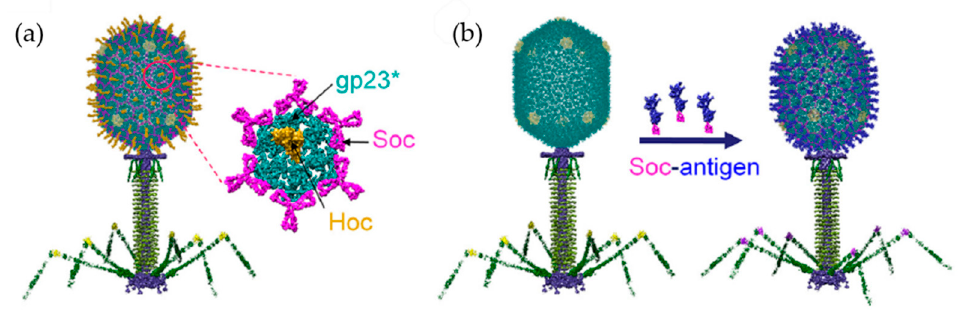
Figure 12. Scheme of the bacteriophage T4 nanoparticle platform and assembly design. ( a ) Structural model of phage T4 with the major capsid protein gp23* (cyan) (the asterisk shows that it is the cleaved form) (930 copies), soc (magenta) (870 copies), and hoc (yellow) (155 copies). ( b ) In vitro assembly of Soc-fused antigen (blue) molecules on hoc_ soc_ T4 phage capsid. Reprinted from [104].